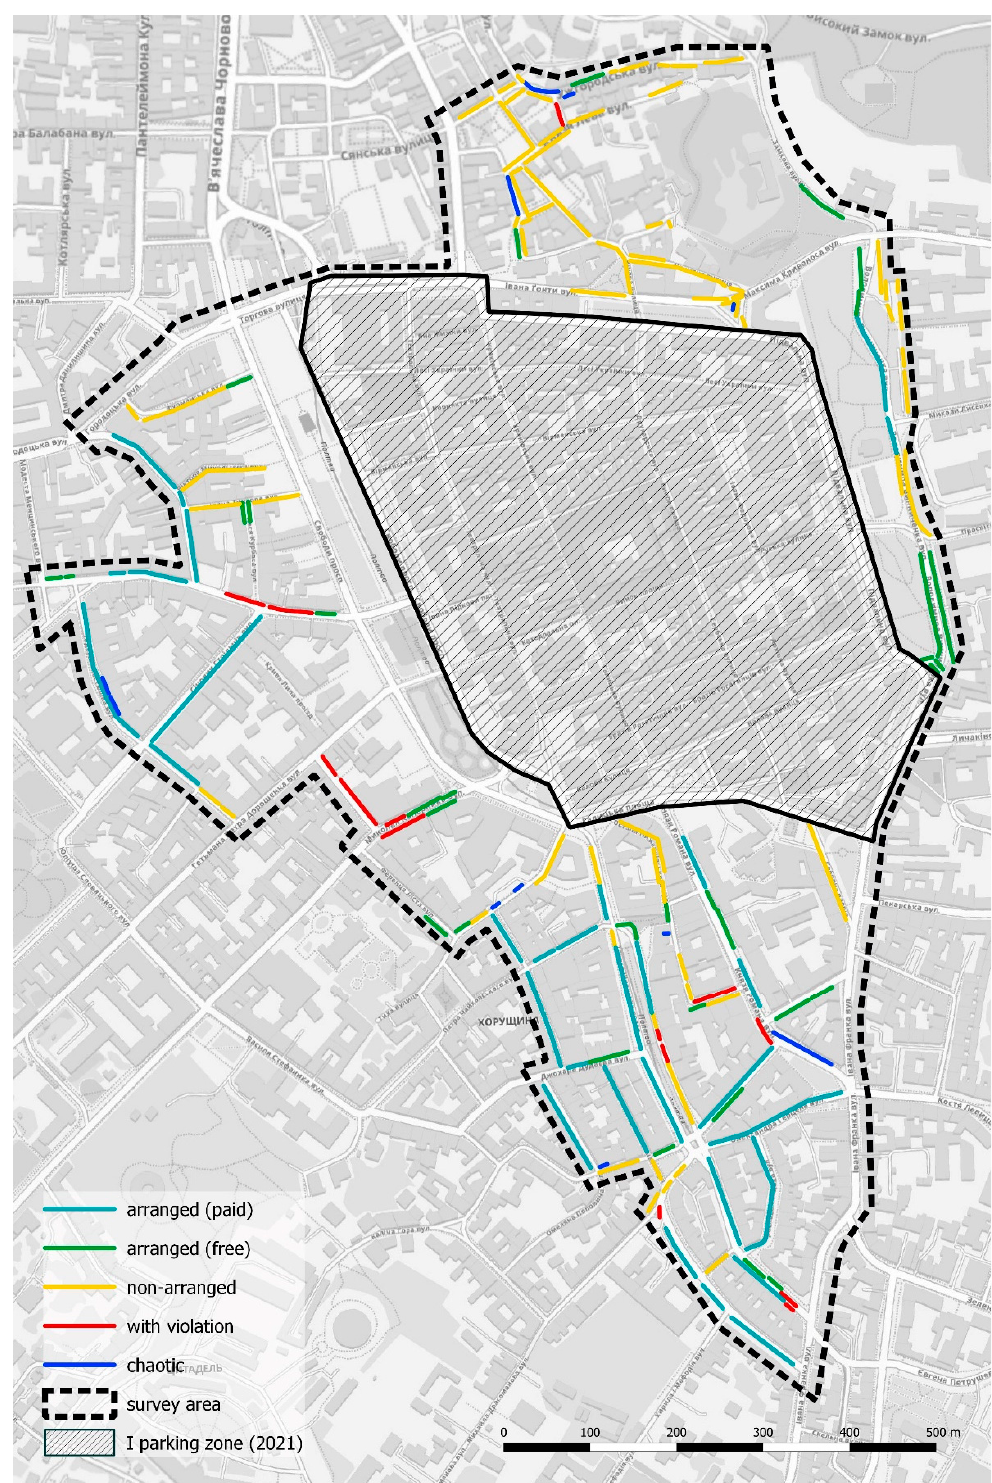
Figure 7. The scheme of on-street parking status in 2021 (“in situ”). Scheme by R. Liubytskyi. Table 3. Results of the on-street parking field survey in the city center, 2021.